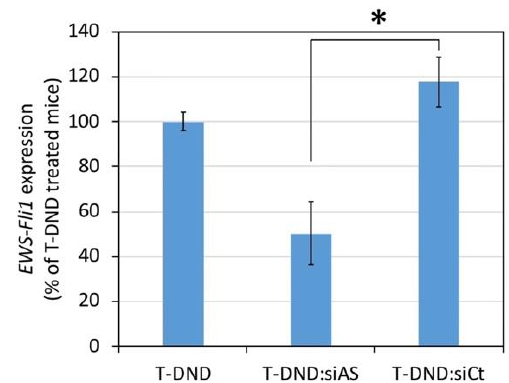
Figure 4. Inhibition of EWS-FLI1 expression in tumor xenografted on mice treated for 24 h by siRNA vectorized by tritiated DND (T-DND) at a mass ratio of 5:1 (T-DND:siRNA). The tumor was formed from A673 Ewing sarcoma cells grafted in the right flank of the mice ( n = 6 to 8 animals per condition). T-DND:siRNA was intravenously injected in the mouse tail vein. RNA was extracted from the tumor of mice sacrificed 24 h after treatment, and RT-qPCR was performed using GAPDH as housekeeping gene. Standard error on the mean are indicated. siAS:siRNA against EWS-FLI1 oncogene; siCt: irrelevant. A significant difference between T-DND:siAS and T-DND-siCt is observed (*) according to the p Dunn value <0.05, inferred from a Kruskal–Wallis test ( p = 0.0094) followed by a Dunn multiple comparisons test.